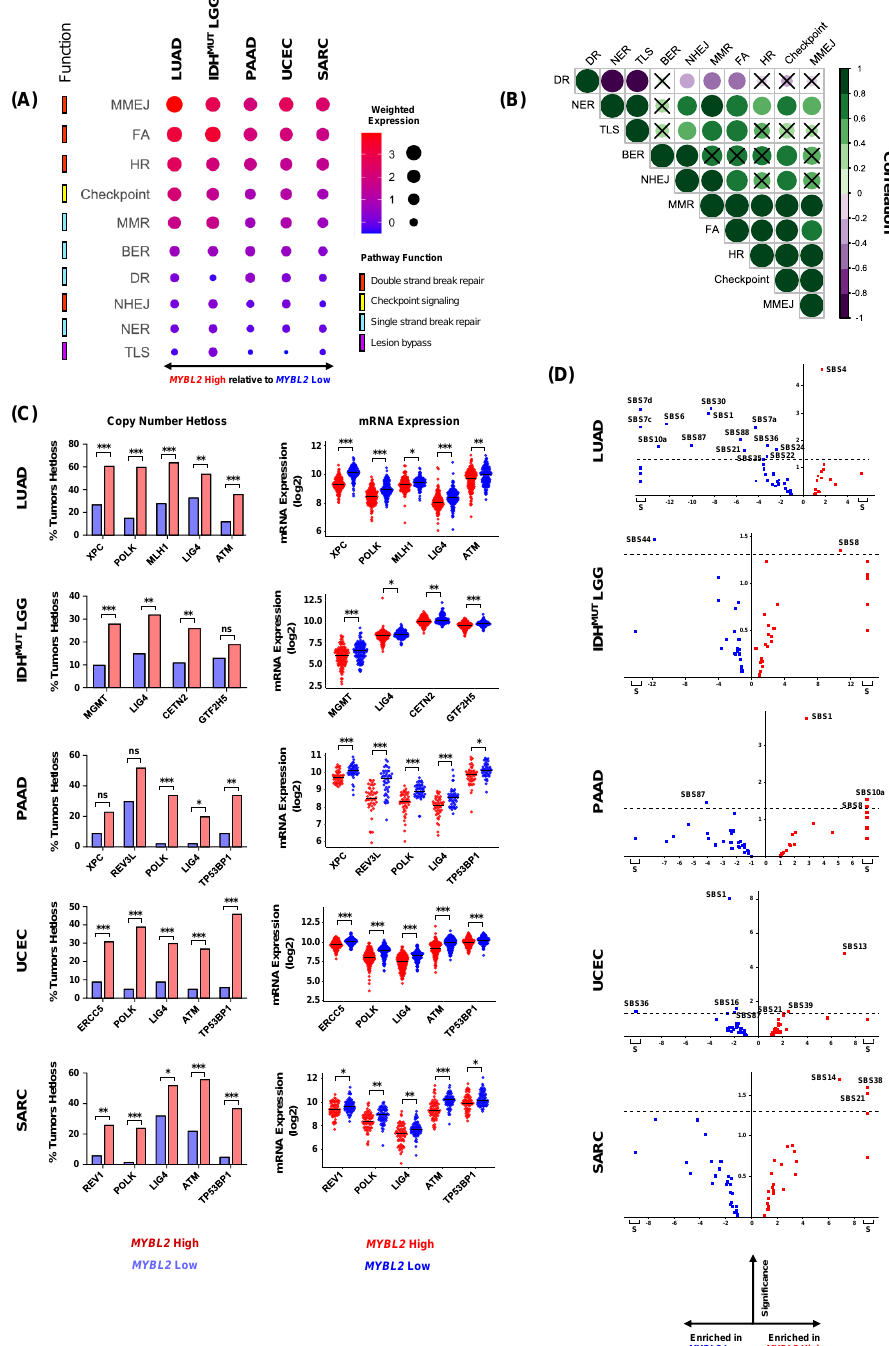
Figure 3. Heterozygous losses impacting key DNA repair effectors are enriched in MYBL2 High tumors. ( A ) Weighted expression scores reveal an imbalance in DNA repair pathway regulation. ( B ) Observed differences in WE scores are highly correlated across different cancer types. Correlations with x marks indicate correlations that are not statistically significant (Pearson). ( C ) Heterozygous losses in genes encoding key single-strand break repair, TLS, and NHEJ effectors are highly enriched in MYBL2 High tumors. One-sided Fisher’s exact test, p < 0.05, *; p < 0.01, **; p < 0.001, ***. Heterozygous loss events are highly correlated with decreased expression of repair effectors. Benjamini-Hochberg corrected q . q < 0.05, *; q < 0.01, **, q < 0.001, ***. ( D ) COSMIC v3.2 SBS analysis reveals heterozygous loss of repair effectors is associated with impaired pathway function. S: Signatures specifically observed only in MYBL2 High or MYBL2 Low tumors. Dotted line represents Student’s t -test p =